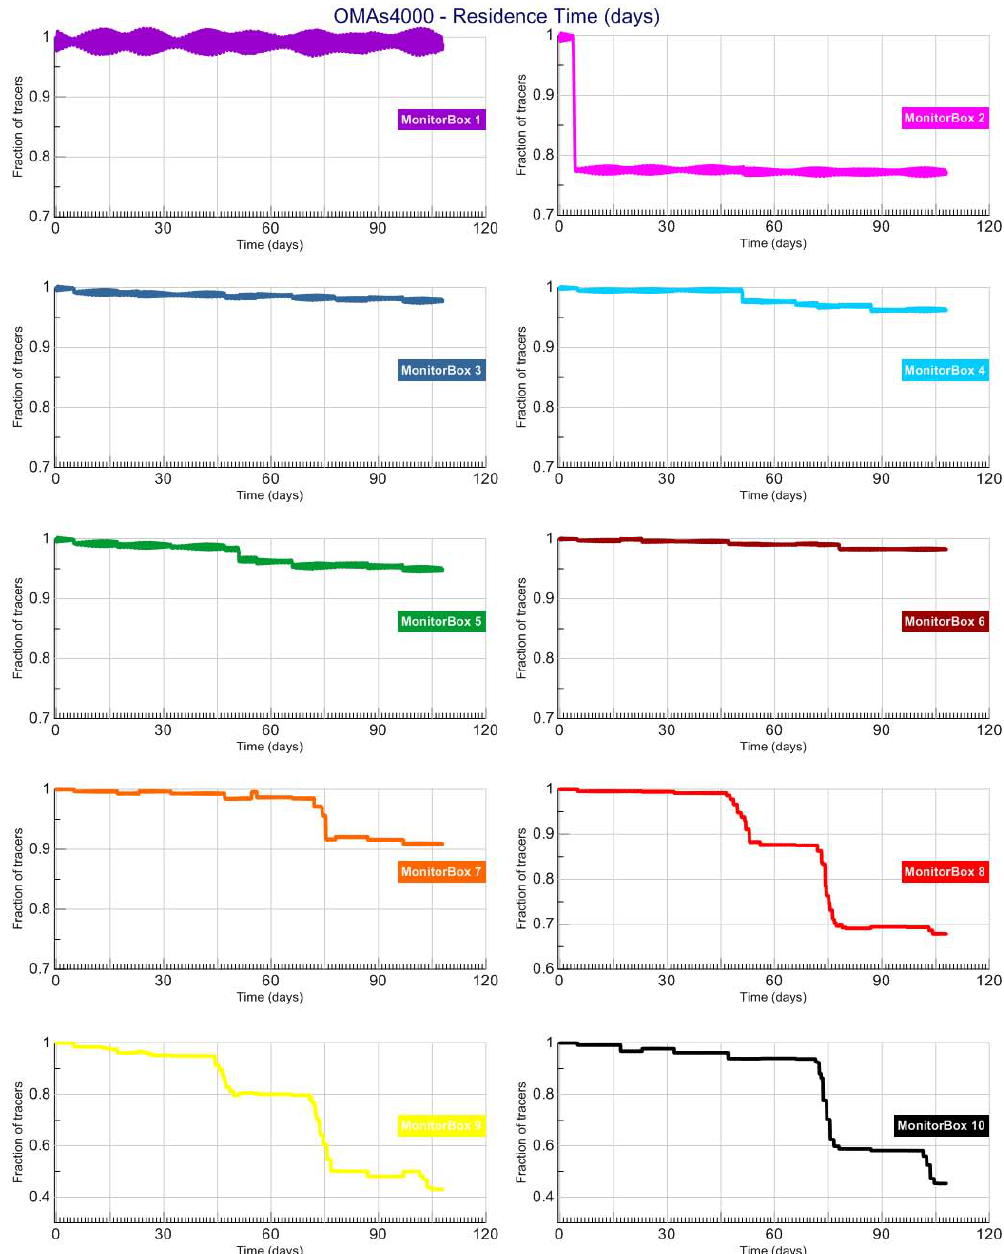
Fig. 5. The residence time of the 4000µm OMAs in each monitor box over the simulated period. The monitor boxes are set at increasing depths from box 1 to box 10: 59m, 262m, 357m, 575m, 331m, 945m, 1498m, 2077m, 2657m, and